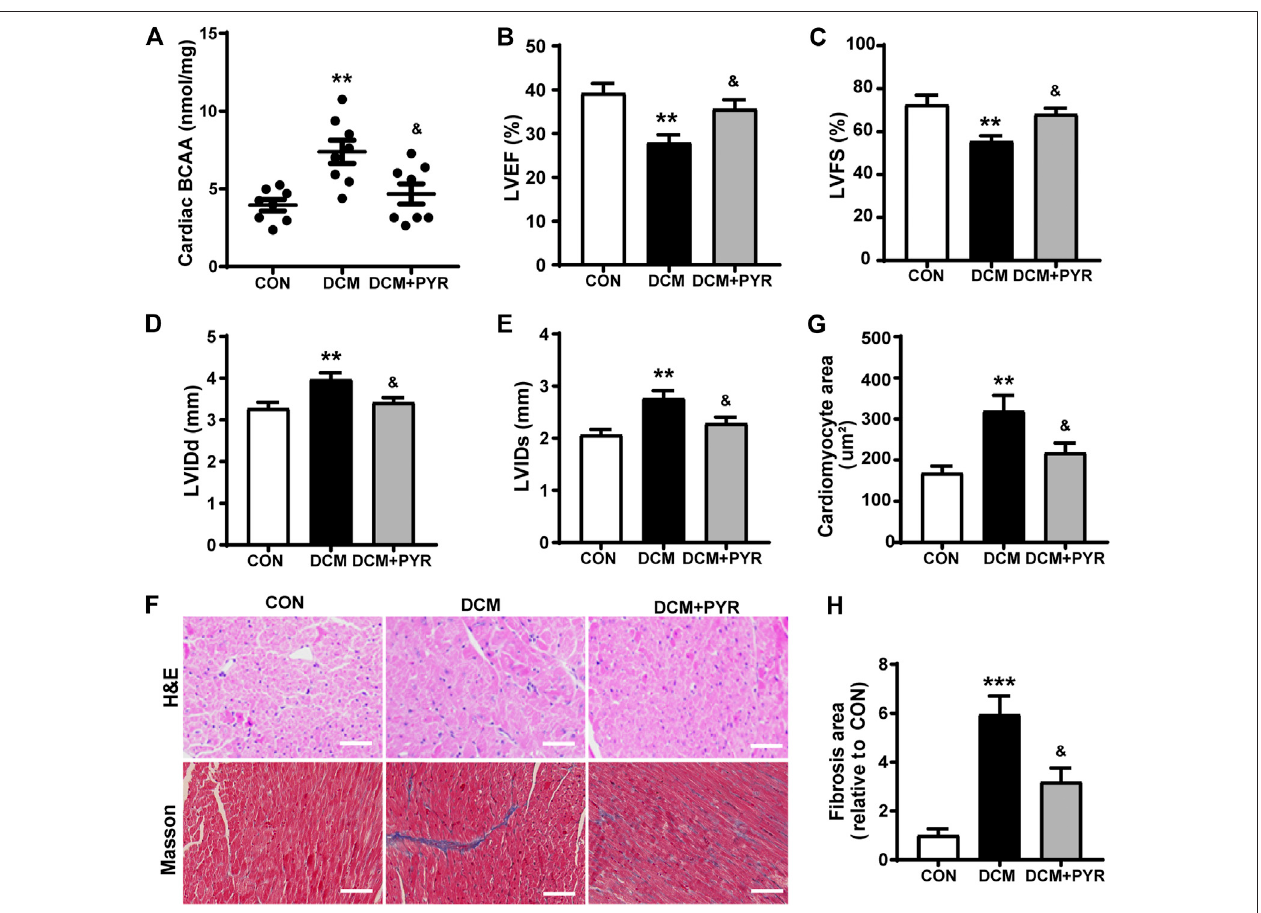
FIGURE 6 | Pyridostigmine decreased cardiac BCAA concentrations to attenuate cardiac damage in diabetic mice. (A) BCAA concentrations in cardiac tissue. (B – E) LVEF, LVFS, LVIDs, and LVIDd. (F – H) Representative images and quanti fi cation of H&E and Masson ’ s staining of cardiac tissue; scale bar (cid:1) 50 μ m. Data are expressed as the mean ± SEM. n (cid:1) 6 – 8. ** p < 0.01, *** p < 0.01, vs. CON; & p < 0.05, vs.